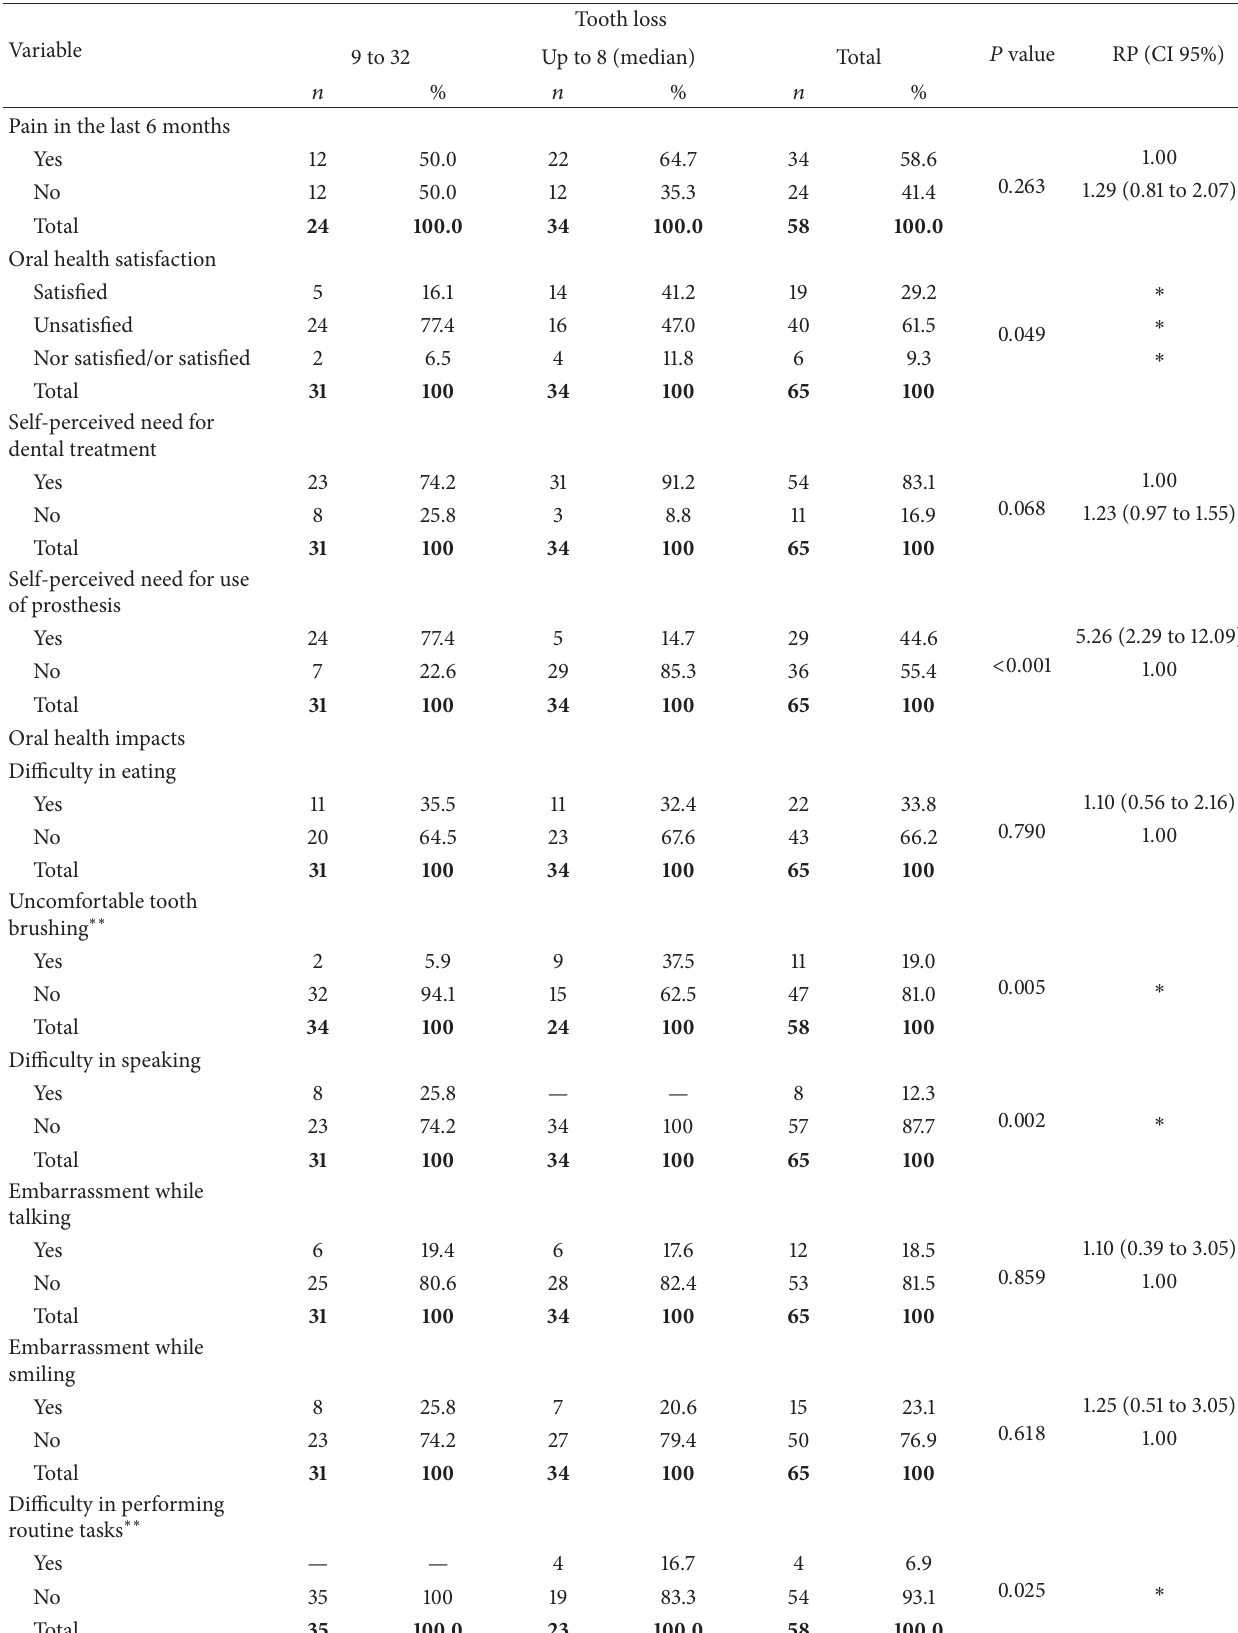
Table 4: Relationship between tooth loss, tooth pain, oral health satisfaction, self-perception, and